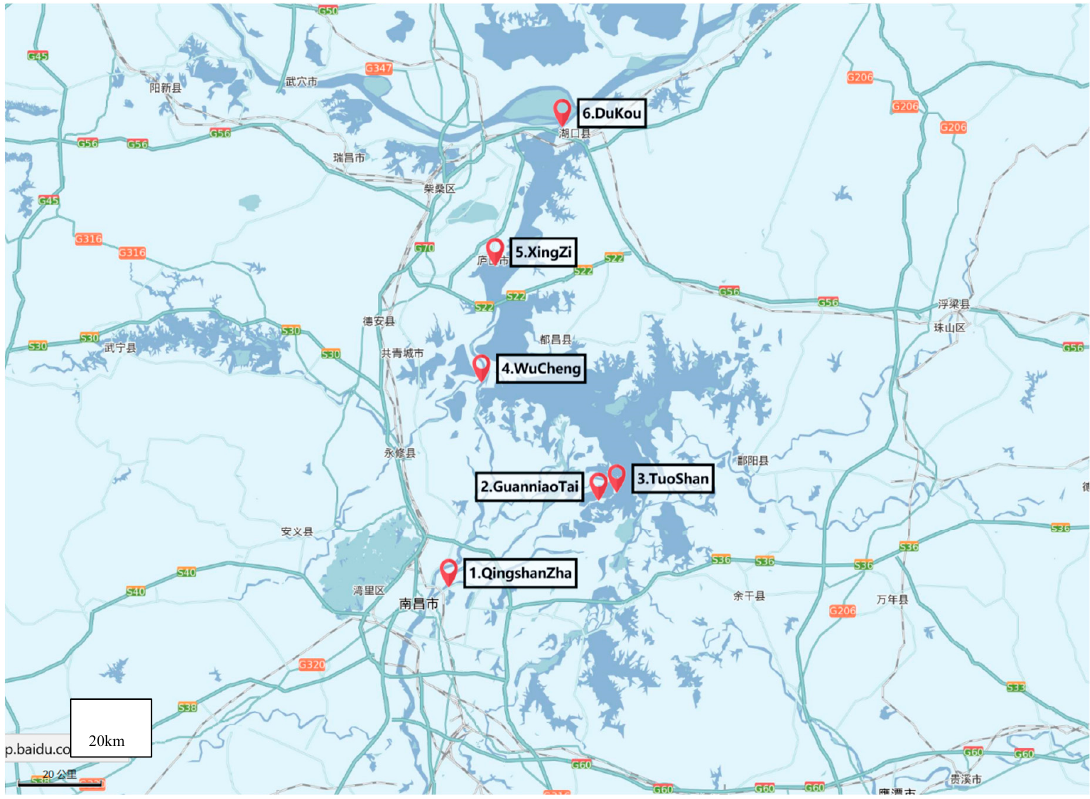
Figure 3. Distribution of sampling sites in Poyang lake.